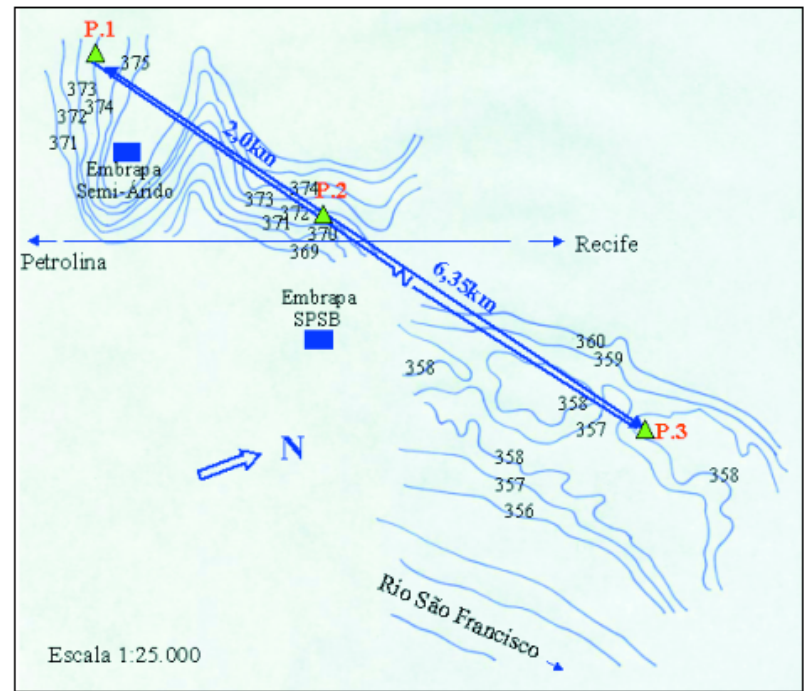
Figura 2. Situação planialtimétrica da área estudada e distribuição espacial dos perfis.